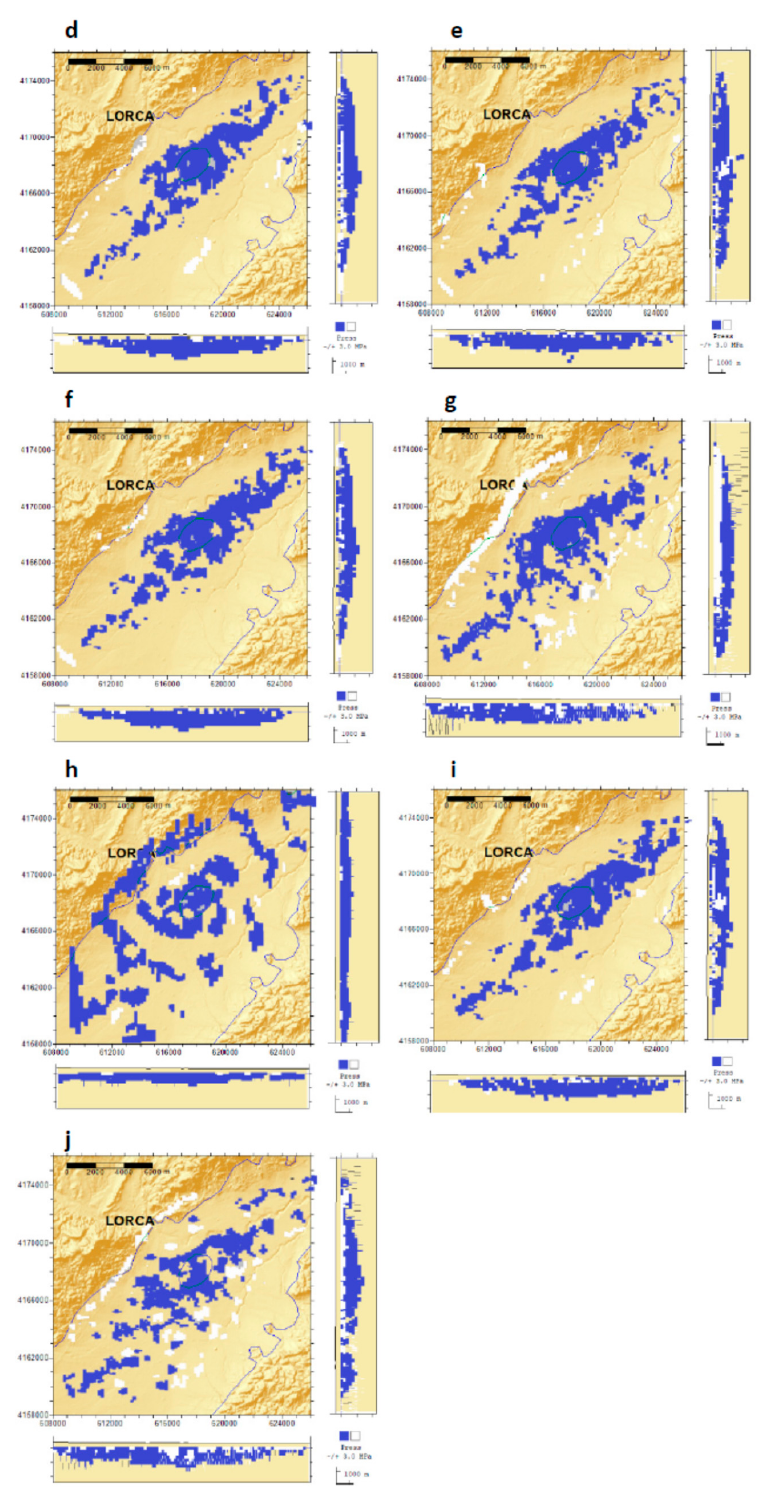
Figure 25. Representation of the inversion results obtained for the 1D, 2D, 3D and 2D + 3D considered Figure 26. Representation of the inversion results obtained for the 2D, 3D and 2D+3D data sets. (d) data sets. ( a ) Obtained source for Case A; ( b ) for Case B; ( c ) for Case C; ( d ) Results for Case D; ( e ) for Results for Case D , (e) for Case E , (f) for Case F , (g) for Case G , (i) for Case I , and (j) for Case J . Blue Case E; ( f ) for Case F; ( g ) for Case G; ( i ) for Case I and ( j ) for Case J. Blue color indicates negative color indicates negative pressure value cells, produced by water extraction. White color indicates pressure value cells, produced by water extraction. White color indicates positive pressure change cells. positive pressure change cells. These positive pressure sources adjust the errors and the effects of These positive pressure sources adjust the errors and the e ff ects of other deformation sources, di ff erent others deformation sources different from water extraction [5]. from water extraction (e.g., of tectonic origin)